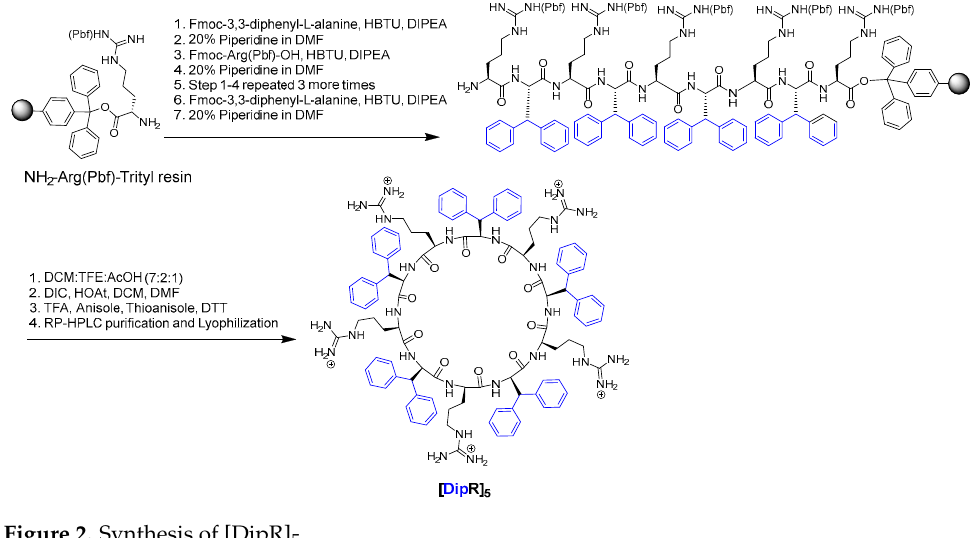
Figure 2. Synthesis of [DipR] 5